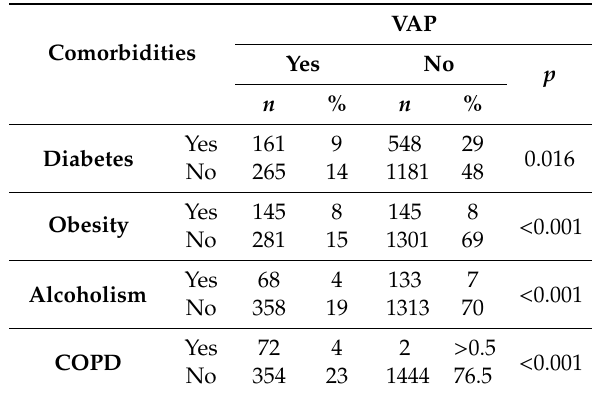
Table 1. Occurrence of VAP in selected comorbidities.